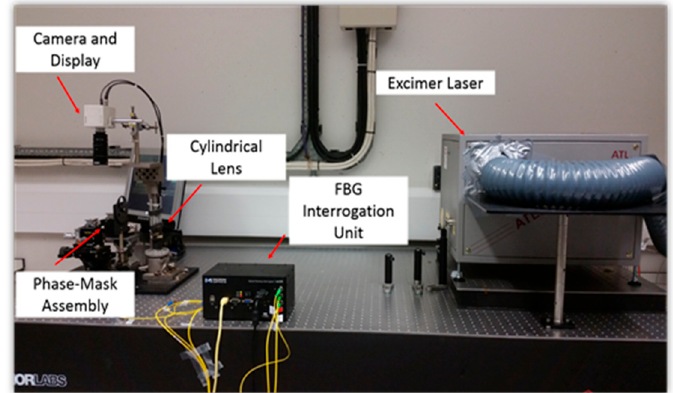
Figure 7. Basic configuration of FBG manufacturing.